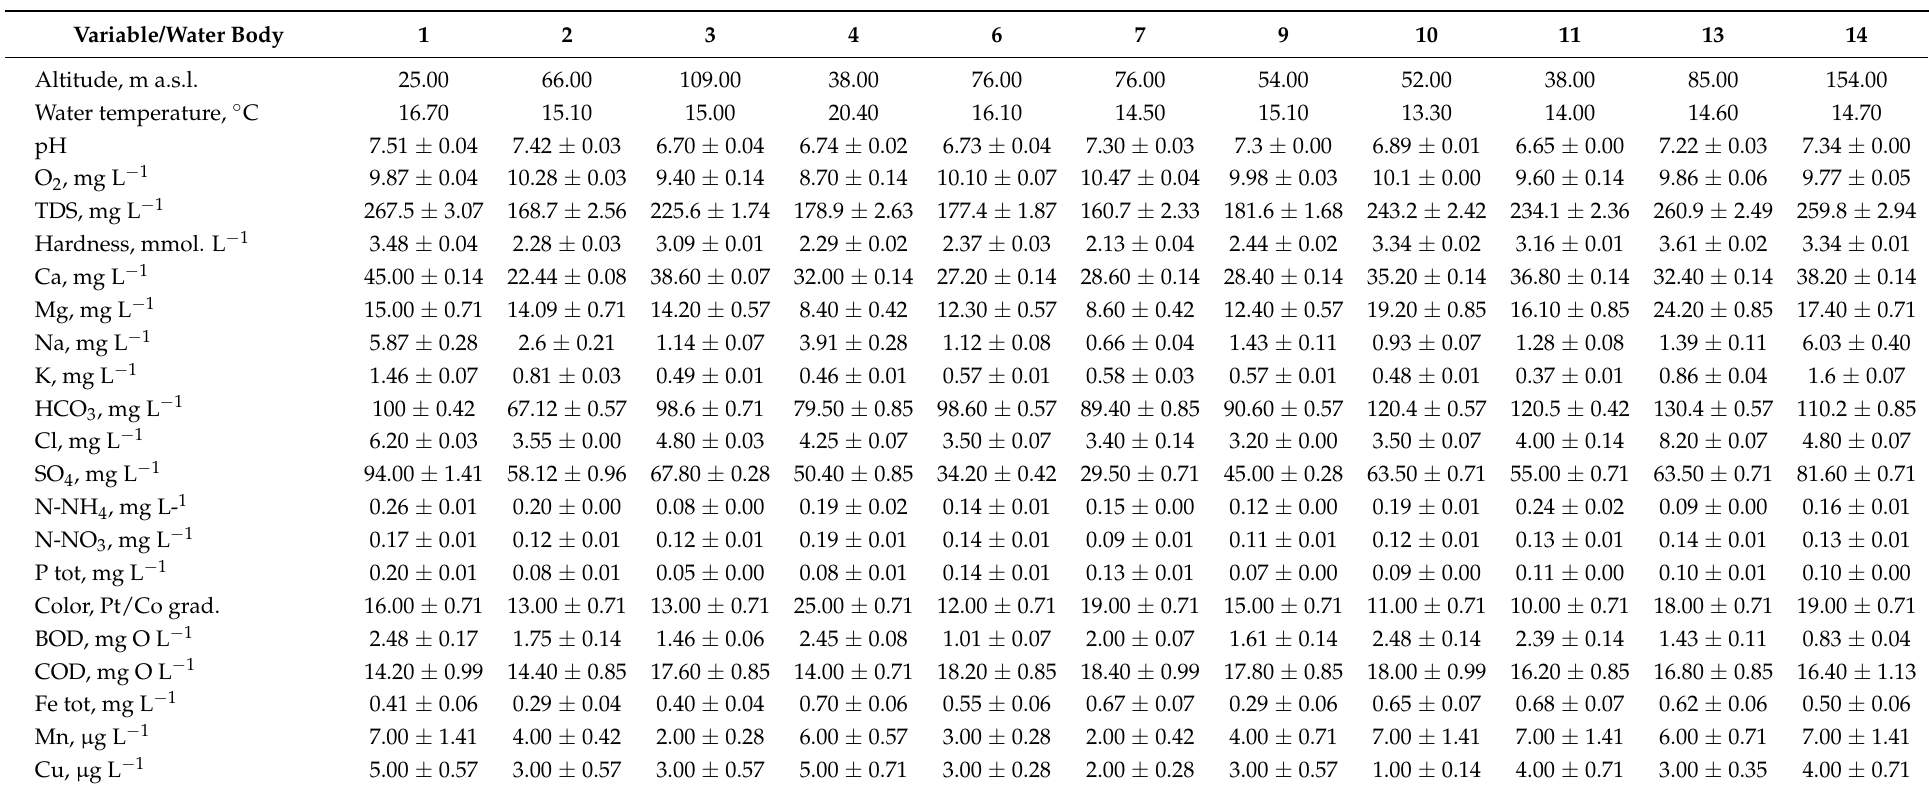
Table A1. Averaged chemical variables with standard deviations of the 11 studied water bodies in the vicinity of Tiksi Bay, July